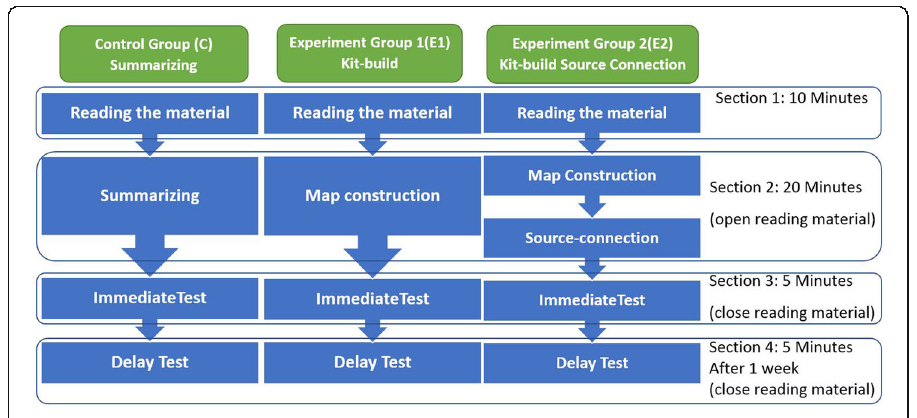
Fig. 4 Session allocation for each group